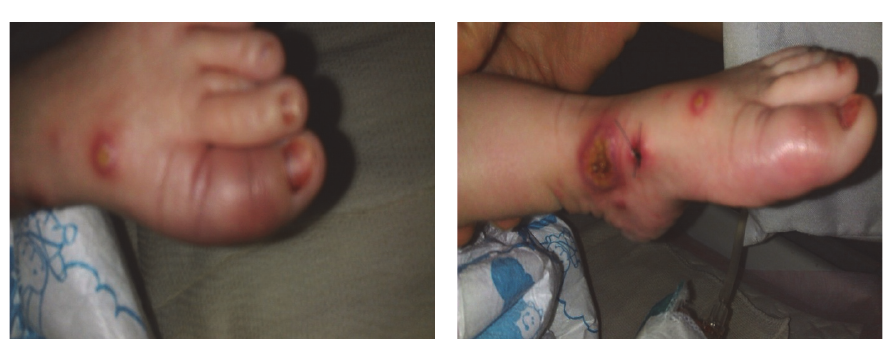
Figure 1: Vesiculopustular lesions ((a)–(d)).